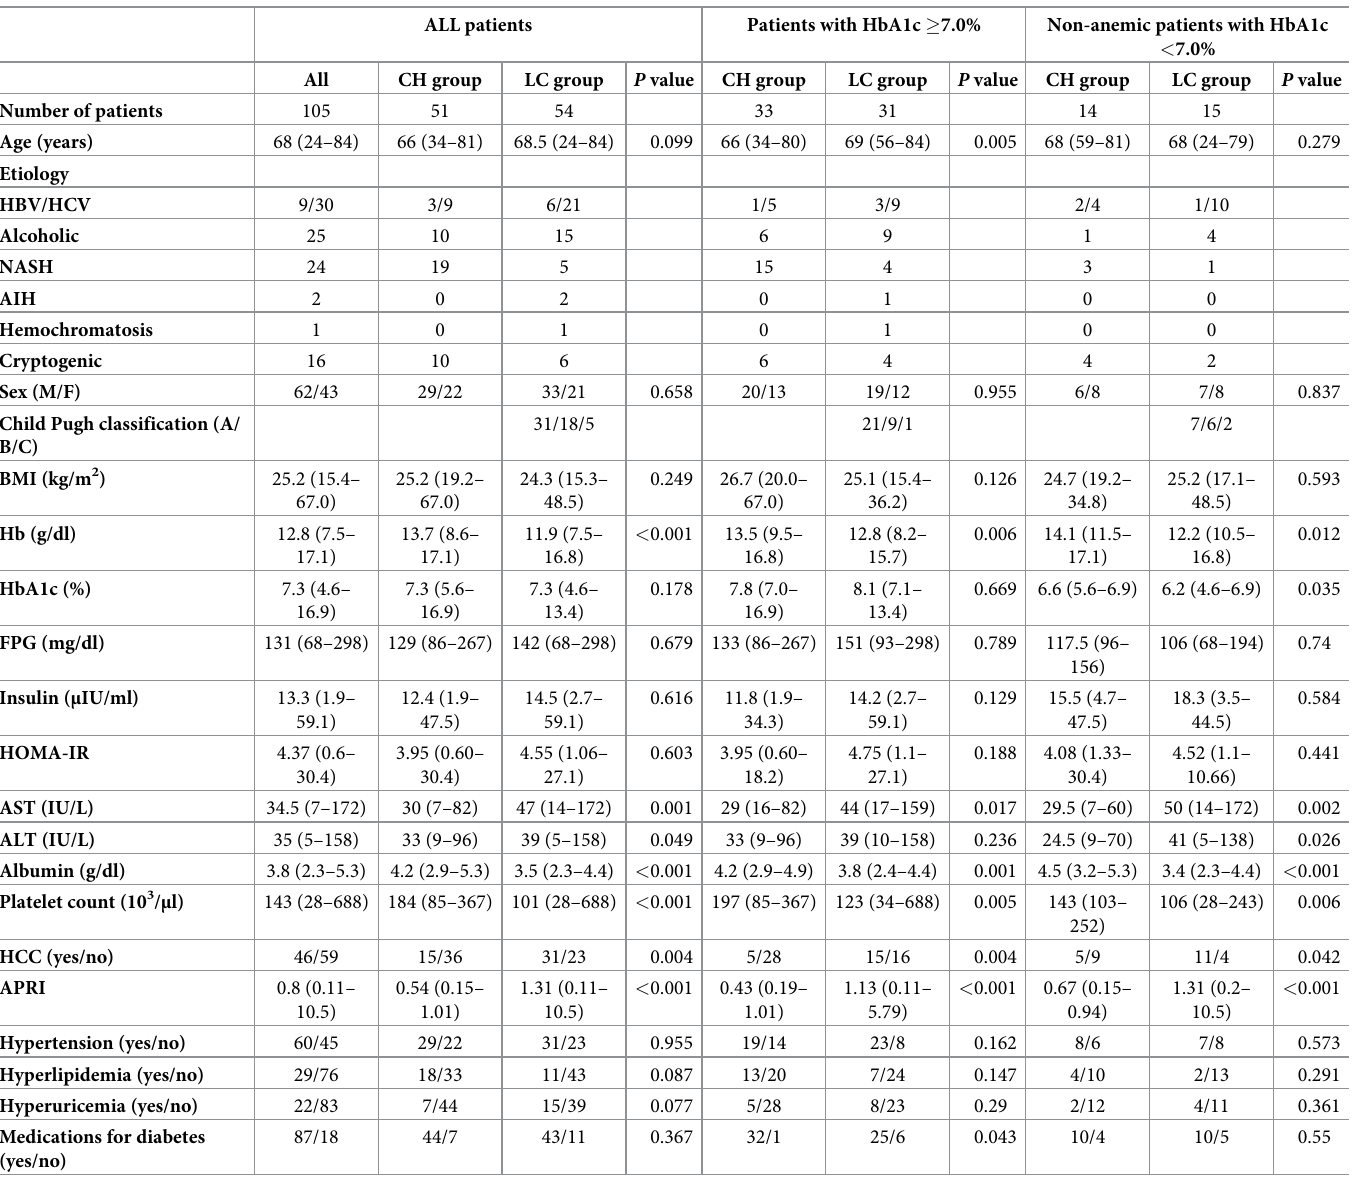
Table 1. Characteristics of patients. ALL patients Patients with HbA1c (cid:21)